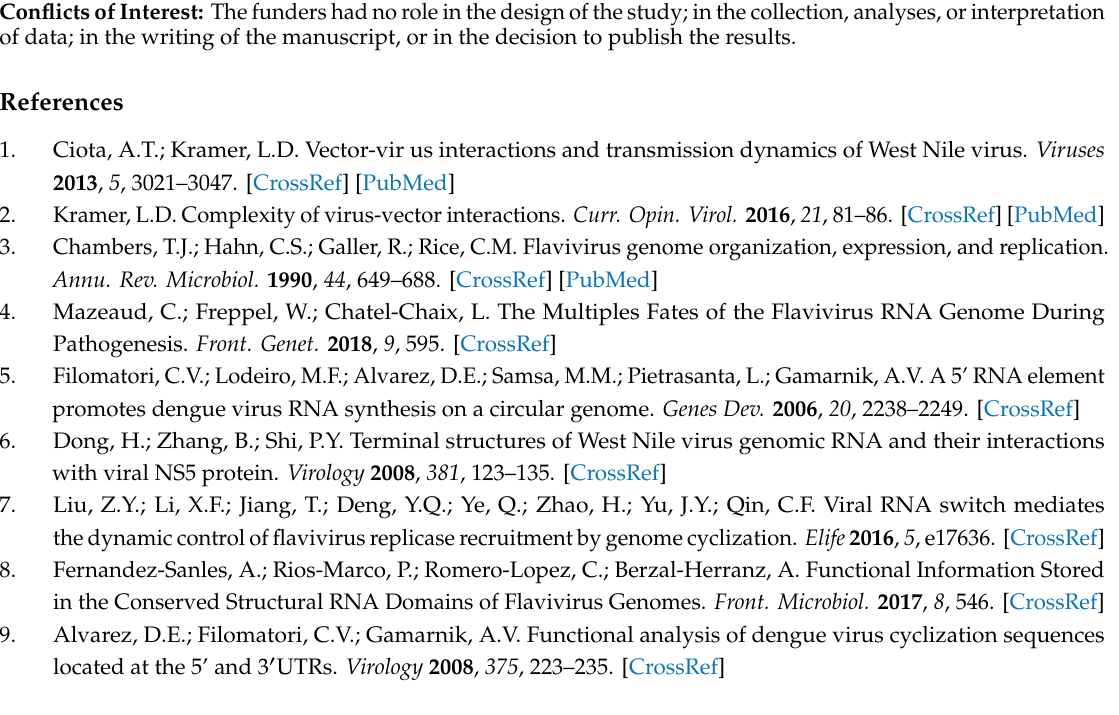
Figure S1: Time course of Rluc activity in cells transfected with WNV replicons, Figure S2: Exon-intron organization of two genomic loci in C6 / 36 cells encoding AUF1-homologous proteins, Figure S3: Mosquito squid p30 and p32 are monomeric proteins, Figure S4: 5’-3 (cid:48) RNA-RNA interaction is increased at higher temperatures, Table S1: DNA oligonucleotides used in this study, Table S2: RNA oligonucleotides used in this